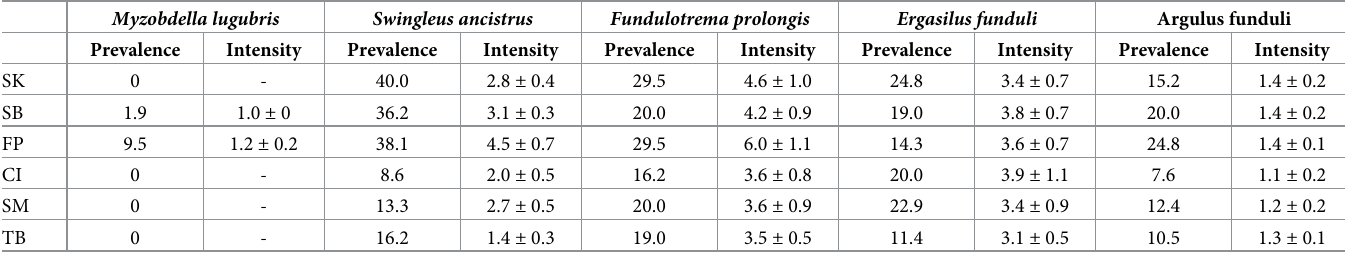
Table 5. Prevalence and mean intensity (SE) of the 5 direct life-cycle parasite taxa infecting the salt marsh fish, F . heteroclitus . Myzobdella lugubris